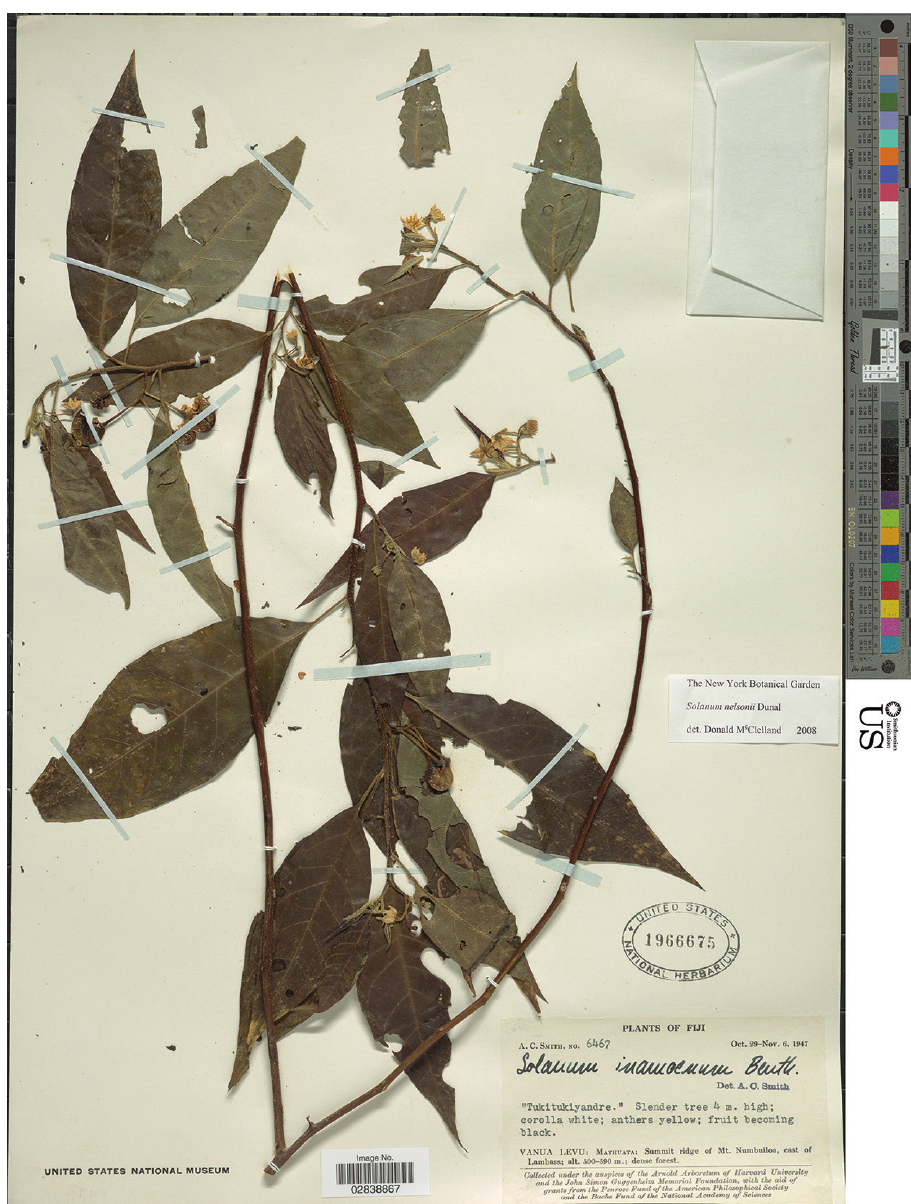
Figure 8. Solanum pseudopedunculatum D.McClelland (holotype Smith 6467 , incorrectly labelled as S. nelsonii . US [acc. # 1966675, barcode 02838867]). Reproduced with permission. apiculate lobe tips, the tube 0.4–0.8 mm long, the lobes 0.5–0.8 mm long, not splitting or splitting in the sinuses during fruit development and then the lobes deltate, sparsely to moderately pubescent abaxially, glabrous adaxially. Corolla ca. 1.5 cm in